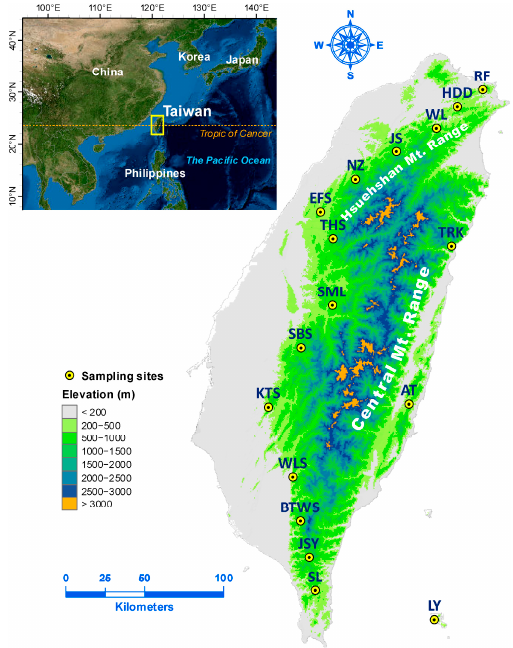
Figure 1. Sampling localities of the 17 Zingiber kawagoii populations. The map was derived from the default map database in ArcGIS v.10.8.1. Sampling site coordinates were used to depict population locations using ArcGIS. The elevation gradient was generated with a 20 m digital elevation model. See Table 1 for abbreviations of the population